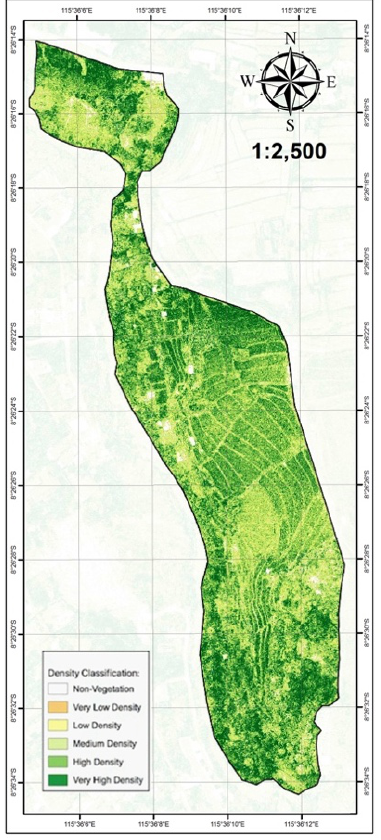
Figure 4 . Vegetation classification results of supervised SVM method and